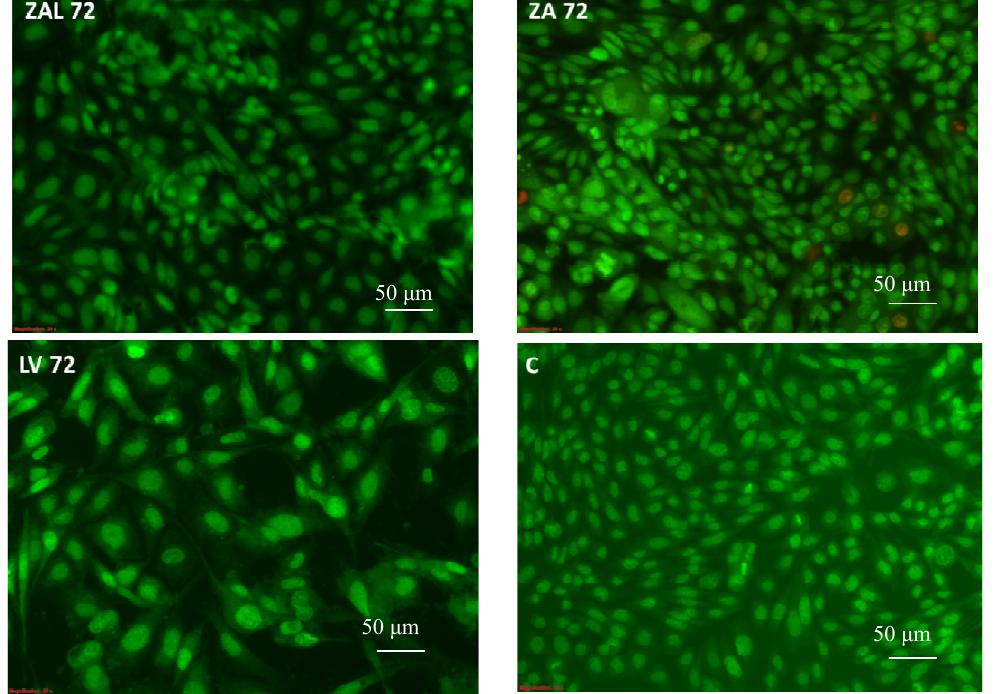
Figure 3. PC12 cell’s morphological appearance on a fluorescence microscope at ×20 values obtained from the proliferation assay and magnification after treatment, with IC 50 stained with acridine orange/propiodine iodide. ZAL, ZA, LV and C are the cells treated with zinc aluminum-levodopa nanoparticle, zinc aluminum nanoparticle, levodopa and untreated (control) after 72 h. These are the viable cells (stained by the acridine orange only) maintaining an ovoid to spherical shape. Scale bar = 50